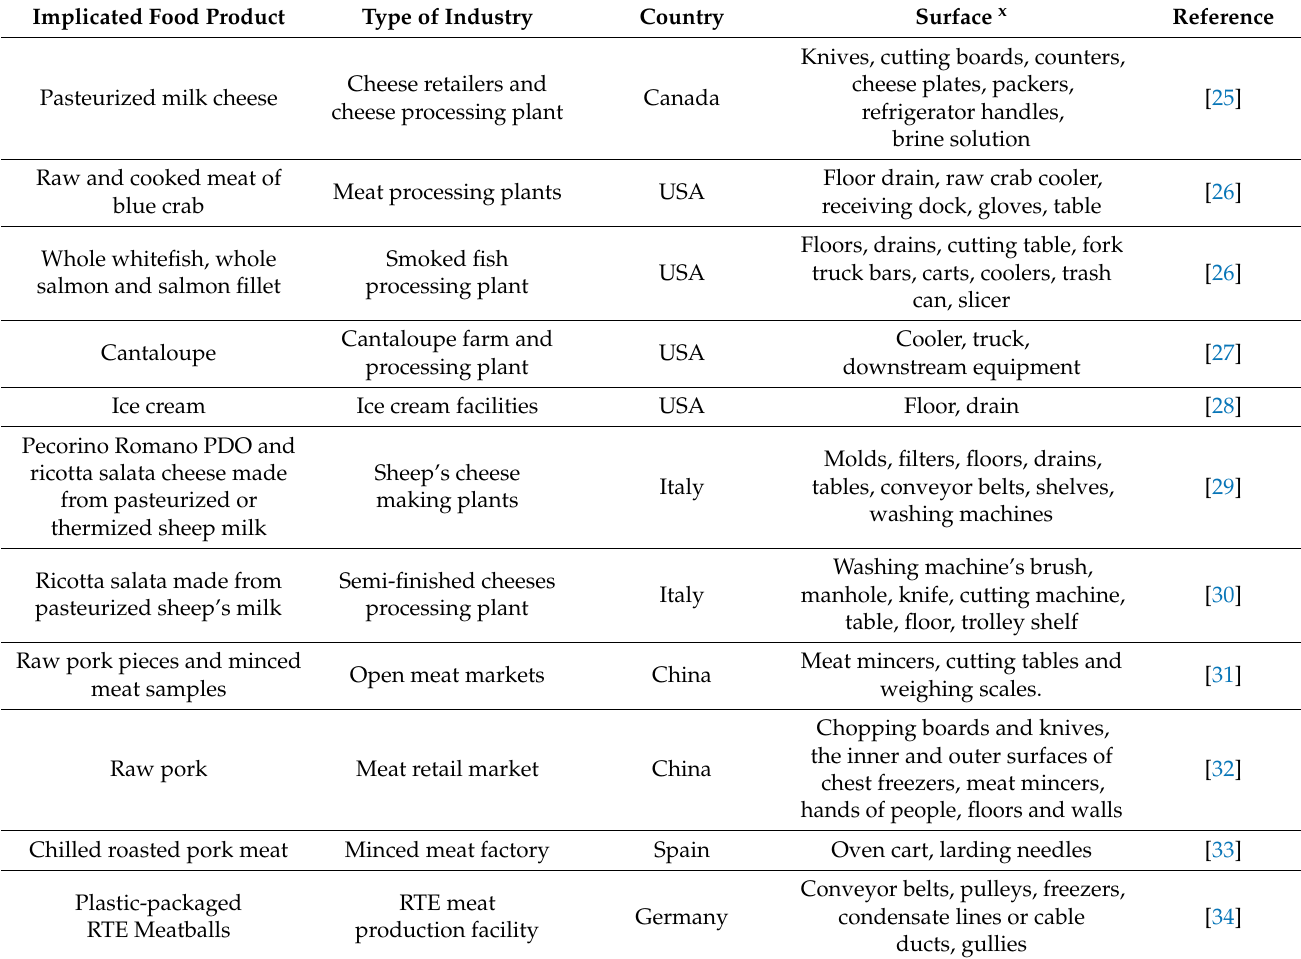
Table 1. Involvement of the environment and the industrial surfaces on the cross-contamination of food-products by Listeria monocytogenes